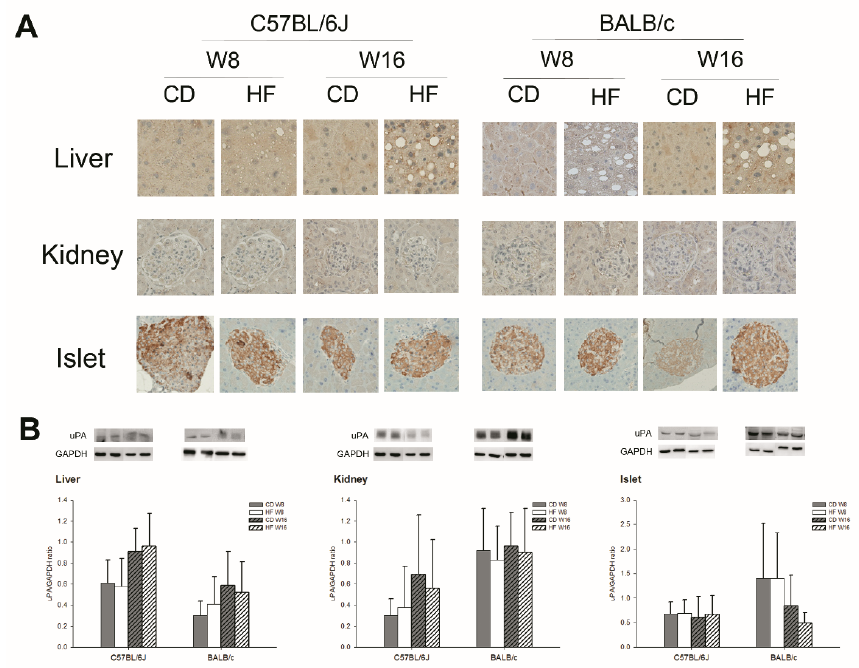
Figure 2. The ( A ) immunohistochemical stain and ( B ) Western blot for uPA expression on liver, kidney and islet tissue in C57BL/6J and BALB/c mice ( n = 5, in each group). In the CD and HFD groups in both strains of mice, the uPA expression in the liver, kidney, and islet did not differ significantly. All figures of IHC stain: 400×.